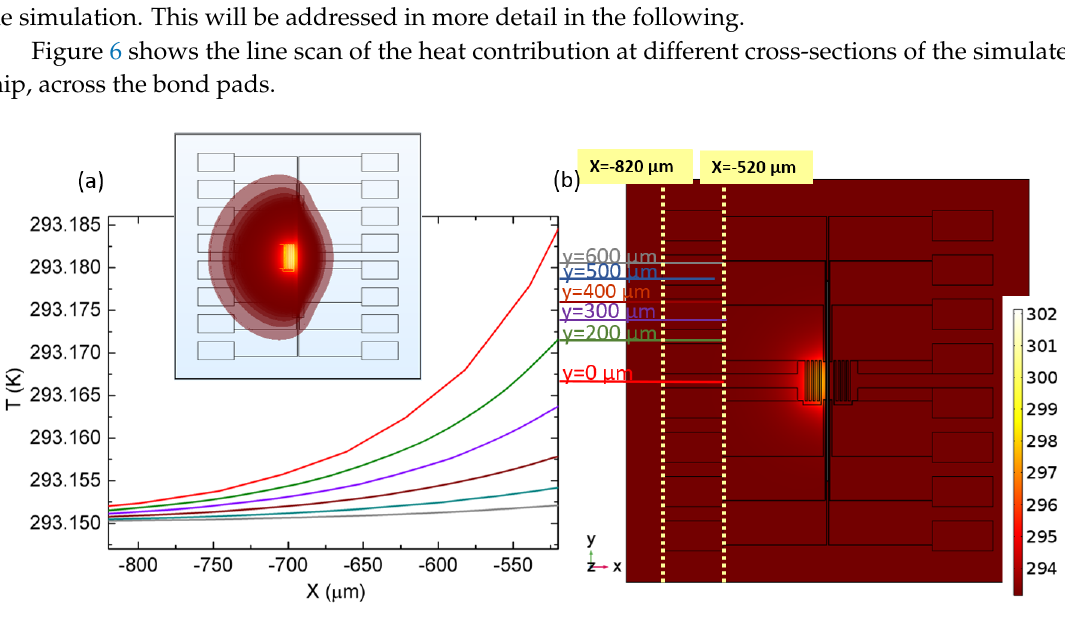
Figure 6. FEM simulation on Platform b ; electrical energy dissipation in the heater structure causes the subsequent heat increase at one side of the gap. ( a ) The heat distribution across the bond pad. The inset shows the isothermal contour of the temperature distribution over the platform. ( b ) xy view of the simulated chip. Getting farther from the heater, the bond pads are more intact (compare the red and grey lines in both diagrams in (a) and